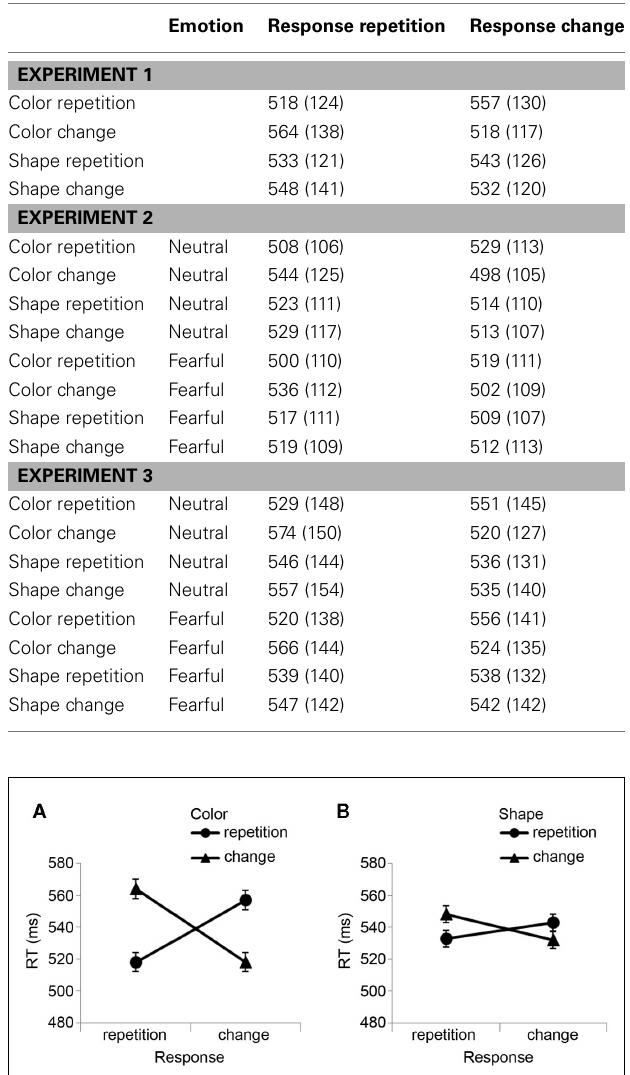
Table 1 | Descriptive statistics for mean R2 response times.